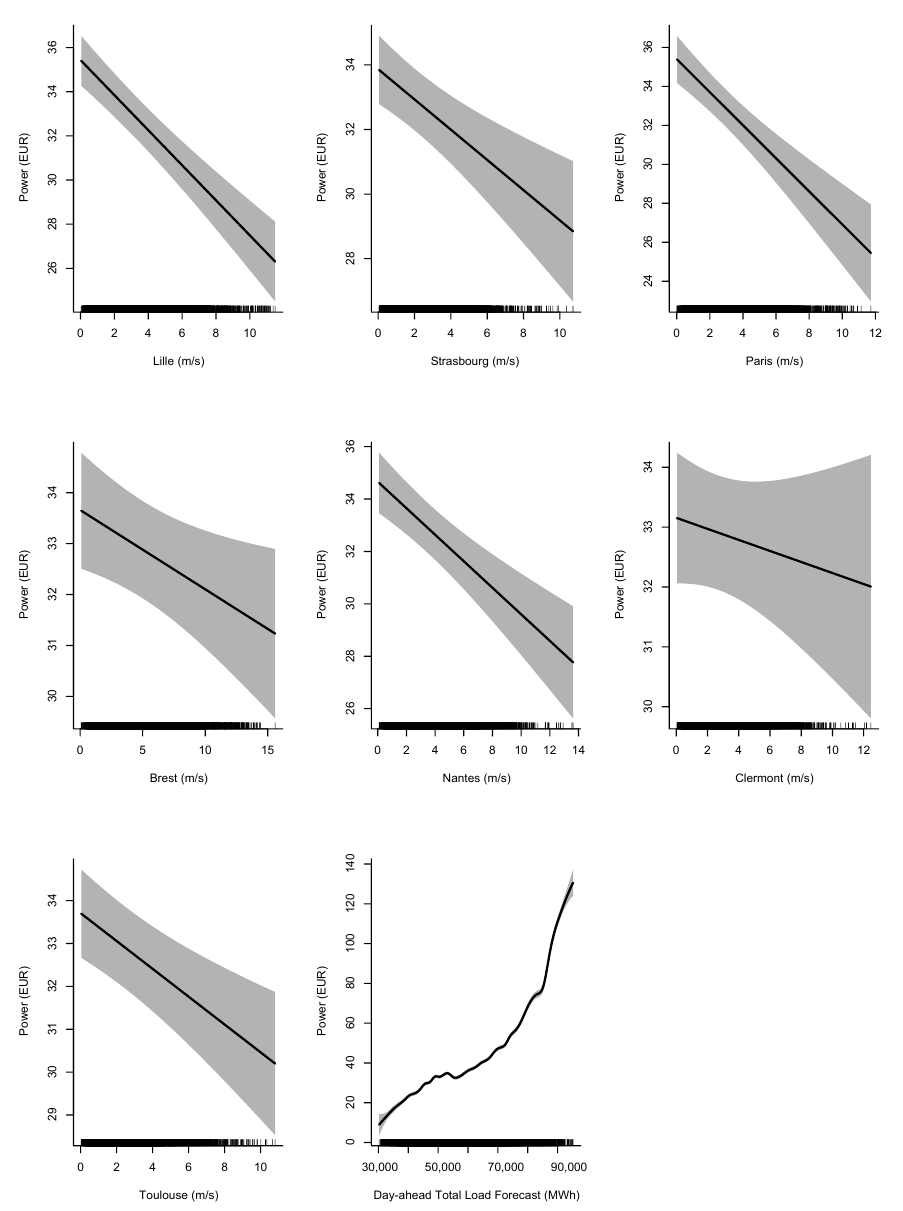
Figure 8. Components of the semi-parametric